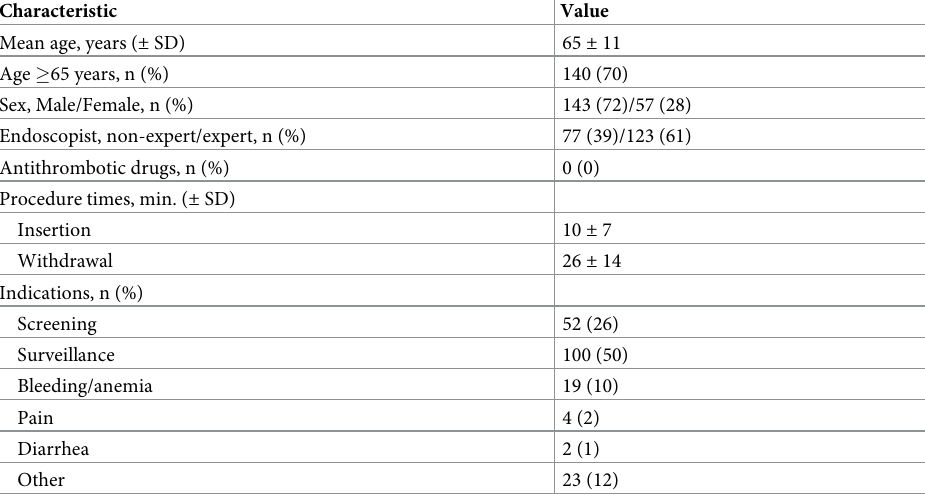
Table 1. Baseline characteristics of patients (n =